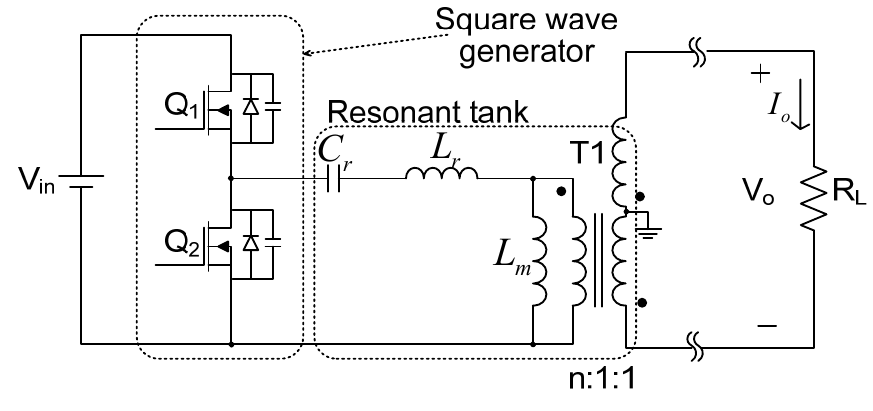
Figure 12. Equivalent circuit of primary side converter.